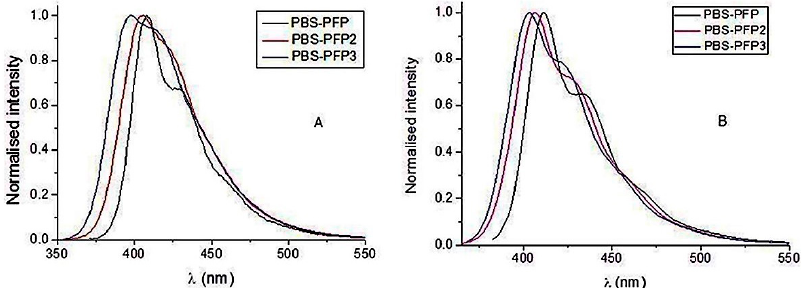
Figure 2. ( A ) Normalized fluorescence spectra in 50% acetonitrile-water for solution of PBS-PFP (6.32 × 10 − 5 M in terms of repeat unit) (black line), PBS-PFP2 (5.69 × 10 − 5 M in terms of repeat unit) (red line), and PBS-PFP3 (4.54 × 10 − 5 M in terms of repeat unit) (blue line). The excitation wavelength was 370 nm. ( B ) Normalized fluorescence spectra in water with the presence of the surfactant C 12 E 5 solution (1 × 10 − 4 M) of PBS-PFP (5.54 × 10 − 5 M in terms of repeat unit) (black line), PBS-PFP2 (6.07 ×